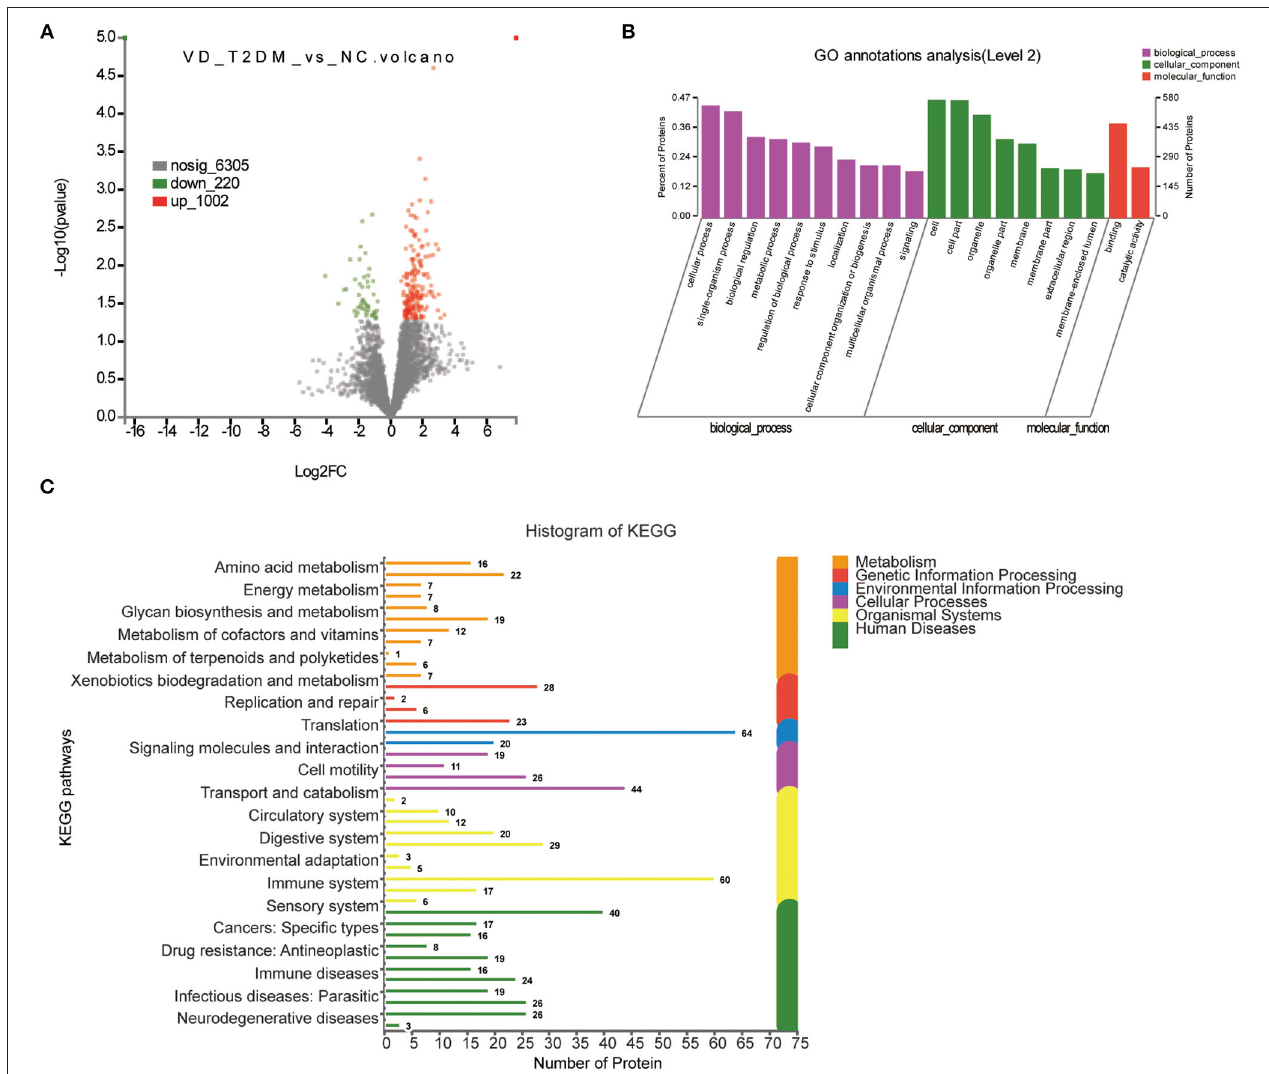
FIGURE 3 | Volcano plots of quantified proteins and functional analysis of the differentially expressed proteins (DEPs) in the urine between subjects with VD + T2DM and NCs. (A) Volcano plot of mean TMT log 2 ratio plotted against –log 10 ( p -value) of the one-sample t -test for the respective quantified proteins. Each point in the figure represents a specific protein. The point on the left is the protein with a downregulated expression, and the point on the right is the protein with an upregulated expression. Green points represent downregulated differential proteins and red points represent upregulated differential proteins. (B) Gene Ontology (GO) enrichment analysis of differential urine-excretory proteins. Purple bars denote the enriched biological processes, green bars denote enriched cellular components, and red bars denote enriched molecular functions. Protein numbers enriched in each category are presented with the bars. (C) The DEPs are associated with diseases and signal transduction pathways. The number of proteins associated with each category is listed. The different color pathways represent the different categories to which they belong. According to the KEGG metabolic pathways involved in proteins, they can be divided into seven categories: metabolism (M), genetic information processing (GIP), environmental information processing (EIP), cellular processes (CP), organismal systems (OS), human diseases (HD), and drug development (DD).